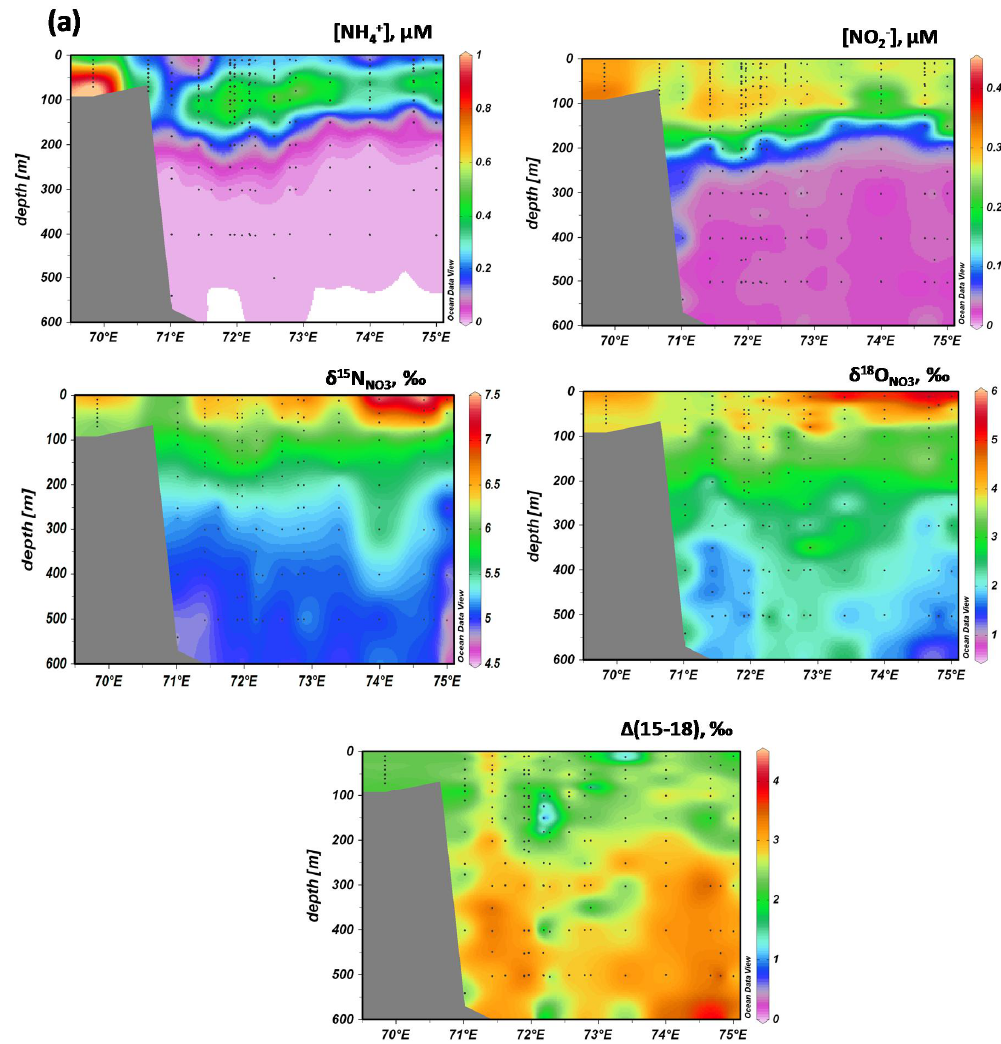
Figure 6. Sections of NH + South to north section. NH +